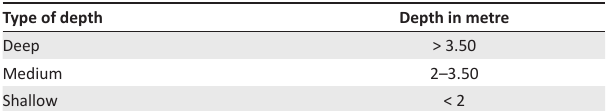
FIGURE 7: Flood water depth map. TABLE 3: Flood water depth with type.